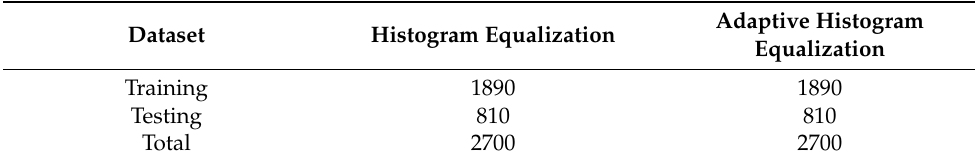
Table 4. Image distribution of